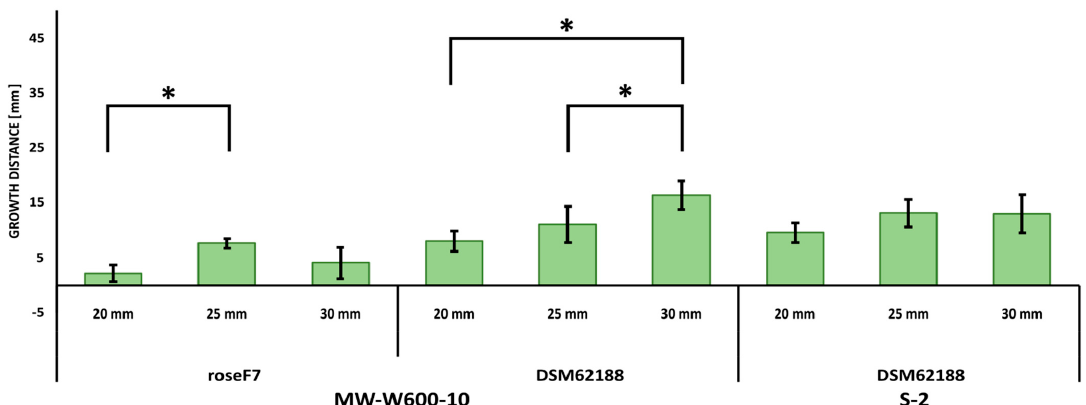
Figure 4. Influence of the distance of the inoculation of Streptomyces on the inhibition of fungi growth. The results present the growth toward the Streptomyces streak at the 14th day of co-culture with bacteria pre-incubated for 3 days. For each experimental setup, 5 biological repeats were performed. Error bars represent the standard deviation of mycelial growth in independent biological repeats. Statistically significant differences between measurements analyzed for each experimental setup separately are marked by “*” (one-way ANOVA, followed by Tuckey’s post hoc test; p ≤ 0.05).